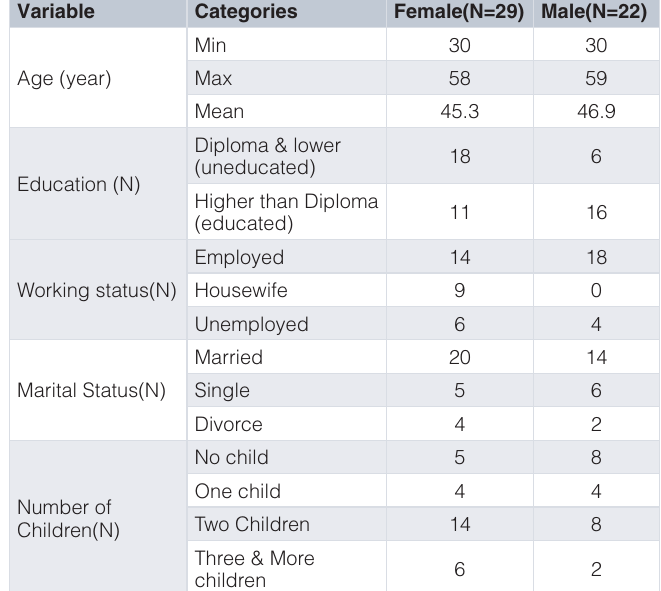
Table 1. Characteristics of participants in focus group